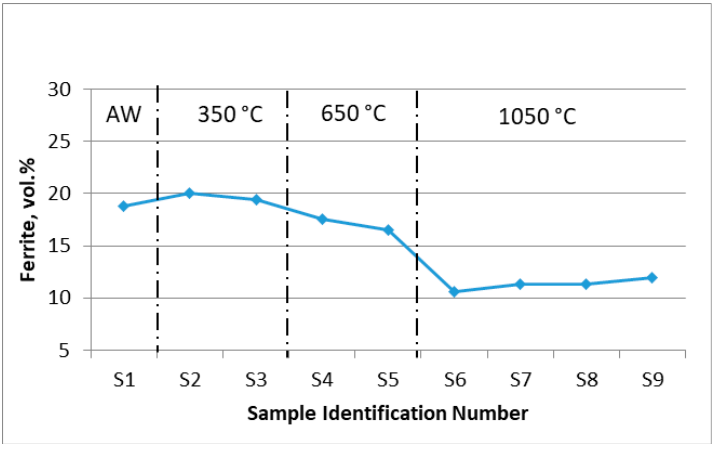
Figure 4. SEM micrographs of the fusion zone of various PWHT (350 °C, 650 °C and 1050 °C).